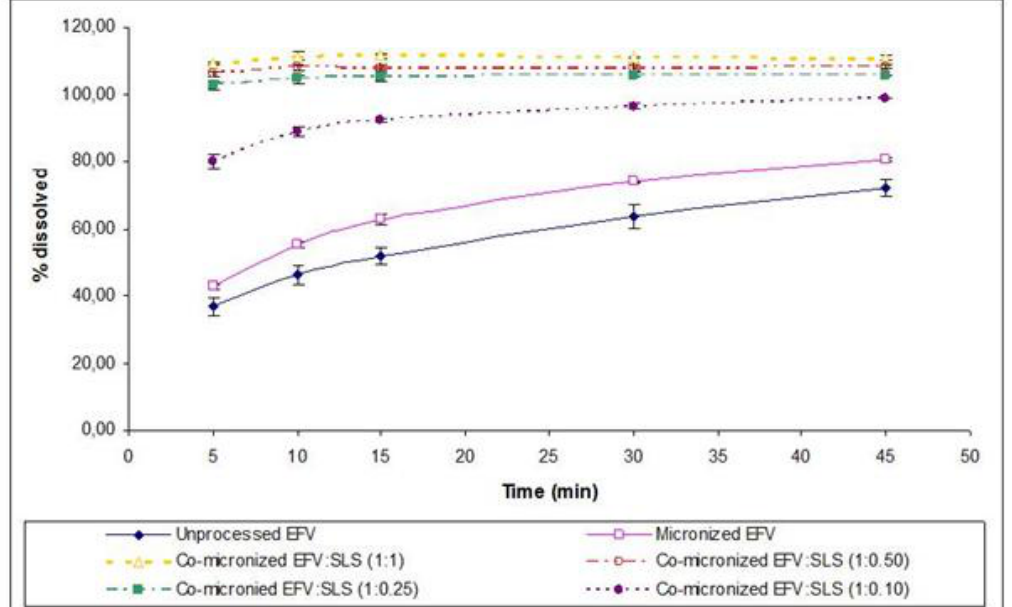
Figure 14. Powder dissolution profile of EFV in SLS 0.5% ( n = 3) compared to micronized and unprocessed EFV and co-micronized EFV:SLS mixtures at the